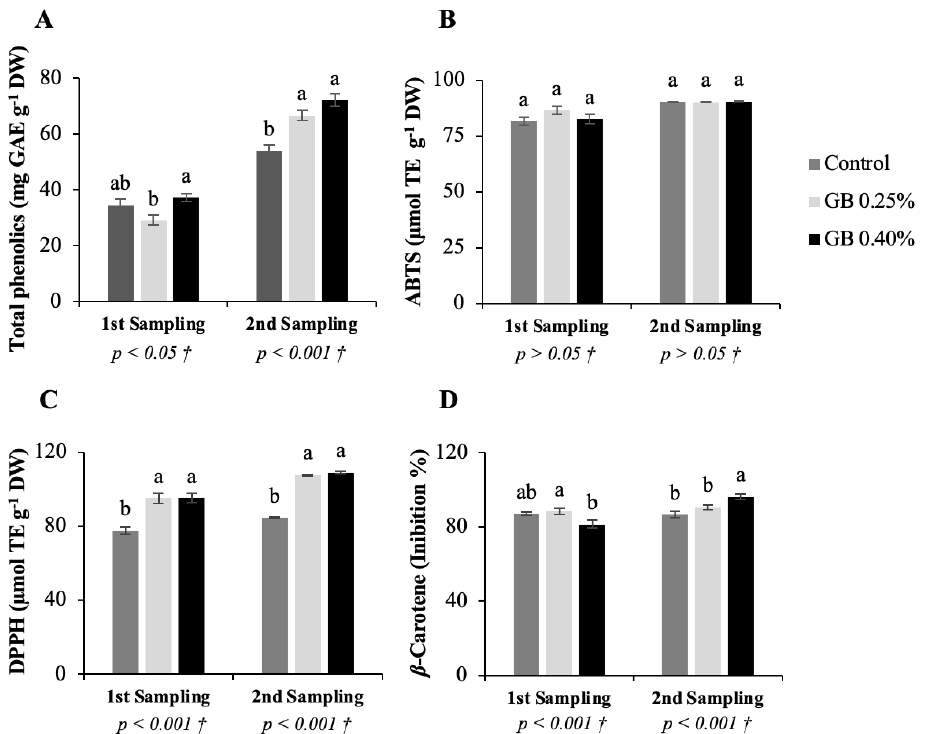
Figure 3. Represents total phenolics and antioxidant activity results in sweet cherry tree leaves. Total phenolic content ( A ) and antioxidant activity by 2,2-azinobis(3-ethylbenzothiazoline-acidosulfonic) acid (ABTS) ( B ), 2,2-diphenyl-1-picrylhydrazil (DPPH) ( C ), and β -Carotene ( D ) methods, for the cv. Lapins leaves subjected to the different treatments. † Indicates the p values were calculated from the